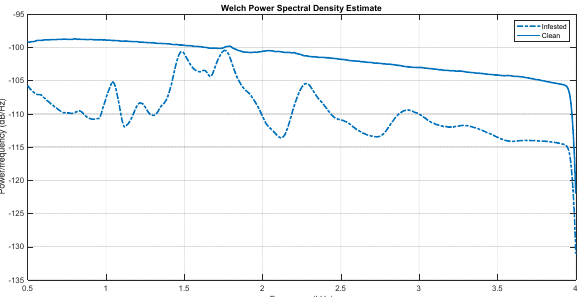
Figure 7. Spectral profile of an infested vs. a non-infested trunk in the laboratory (i.e., no background noise of any kind) through the power spectral density estimate (Welch method). The duration of both recordings is longer than 1 h 30 min. The non-infested trunk is flat indicating practically, a white noise profile. The averaged spectrum of the infested trunk contains the spectral profile of multiple impulses. The variations in the relative magnitude of energy at different frequencies suggests that insect sound bursts are being produced in the trunk.